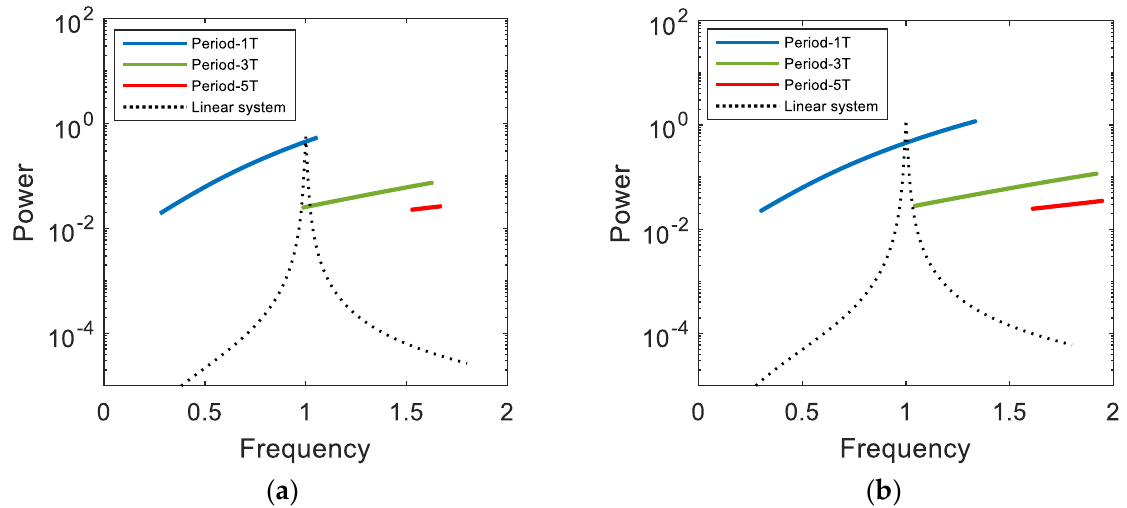
Figure 11. Frequency marching responses for the output powers of the electromagnetic bi-stable energy harvester and its linear counterpart, which are obtained when ( a ) A = 0.02 and ( b ) 0.03.